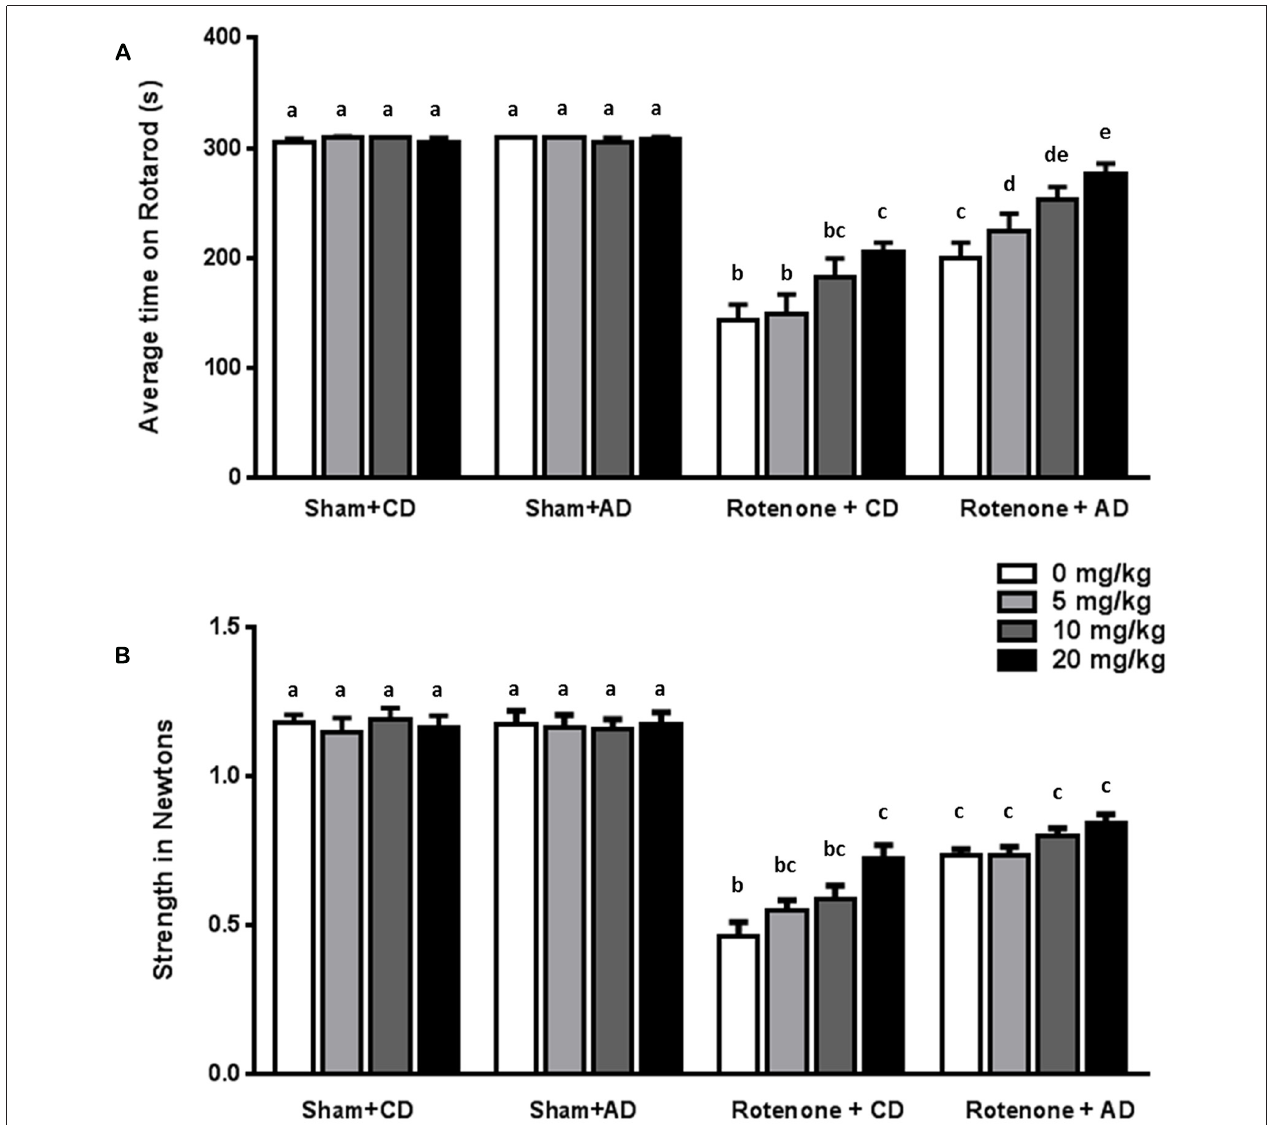
FIGURE 3 | Effects of the dietary intervention and different levodopa doses on (A) rotarod performance and (B) forelimb grip strength. Both levodopa and dietary treatments alleviated rotenone-induced motor dysfunction. The combined administration of the diet and levodopa showed additive beneficial effects on rotarod performance. Data are shown as mean ± SEM. Different letters indicate mean values were significantly different ( p <